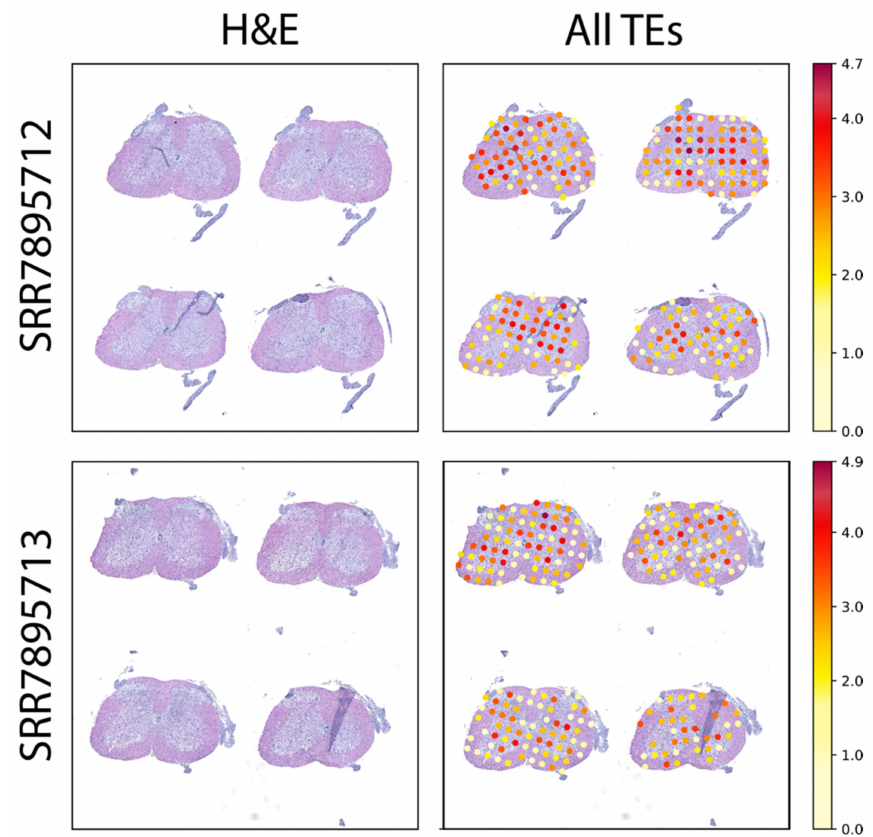
Figure 1. TE expression in the p120 SOD1 G93A mice using samples obtained with the original ST. SRA accession corresponding to each sample is indicated at the left; “H&E”: hematoxylin and eosin-stained tissue; “All TEs”: TE expression per spot over the tissue. Expression levels correspond to log2 normalized counts, with the colour scale indicated at the right (lower values in light yellow, with higher values in dark